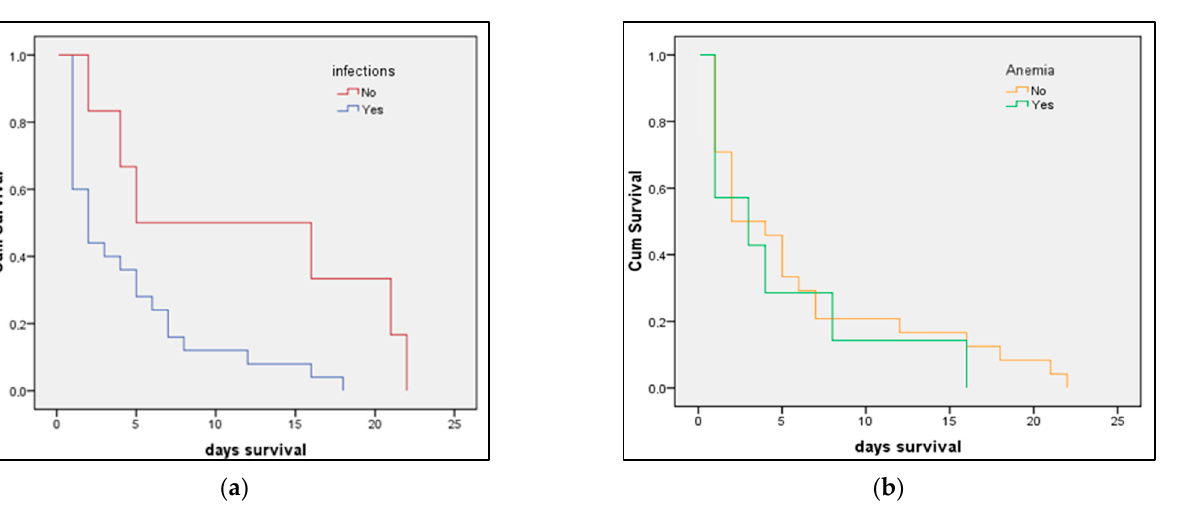
Figure 4. ( a , b ) Kaplan–Meier plots of preterm newborn survival (in days) from mothers with anemia or peripartum infections compared with newborns from mothers without anemia or peripartum infections.